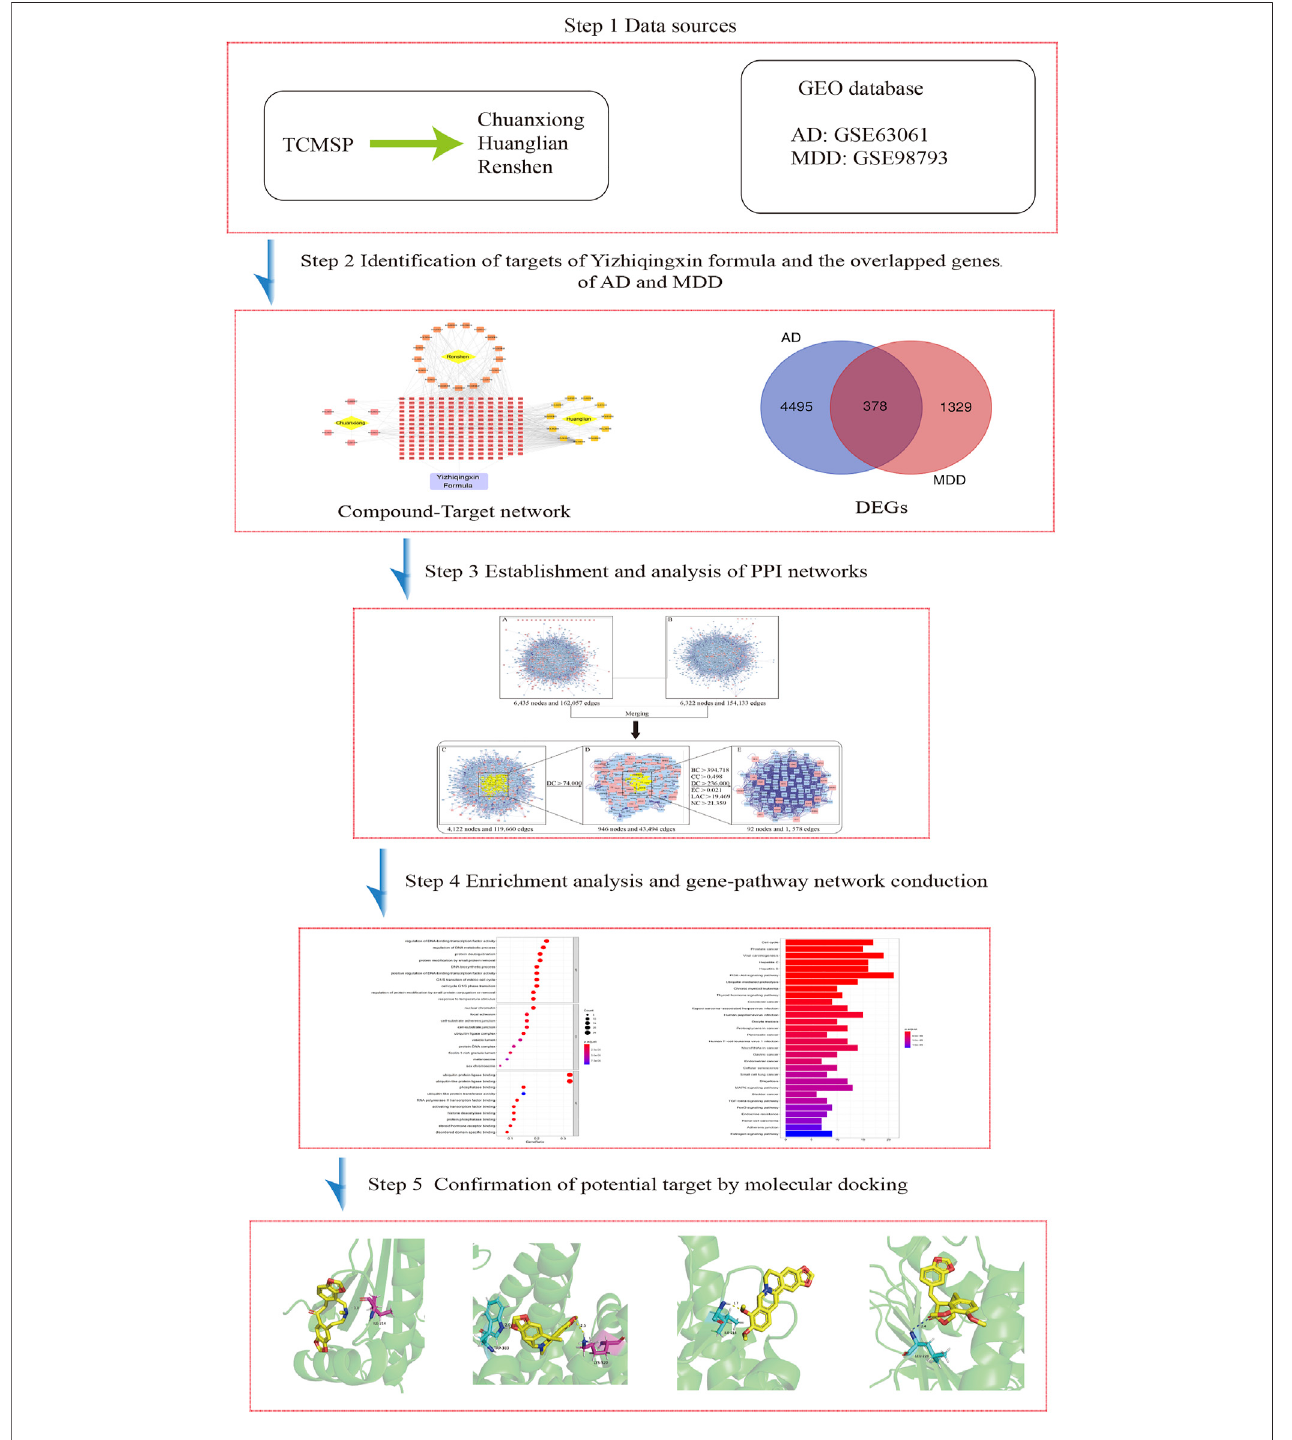
FIGURE 1 | Work fl ow for Yizhiqingxin formula treatment of Alzheimer ’ s disease with depression.